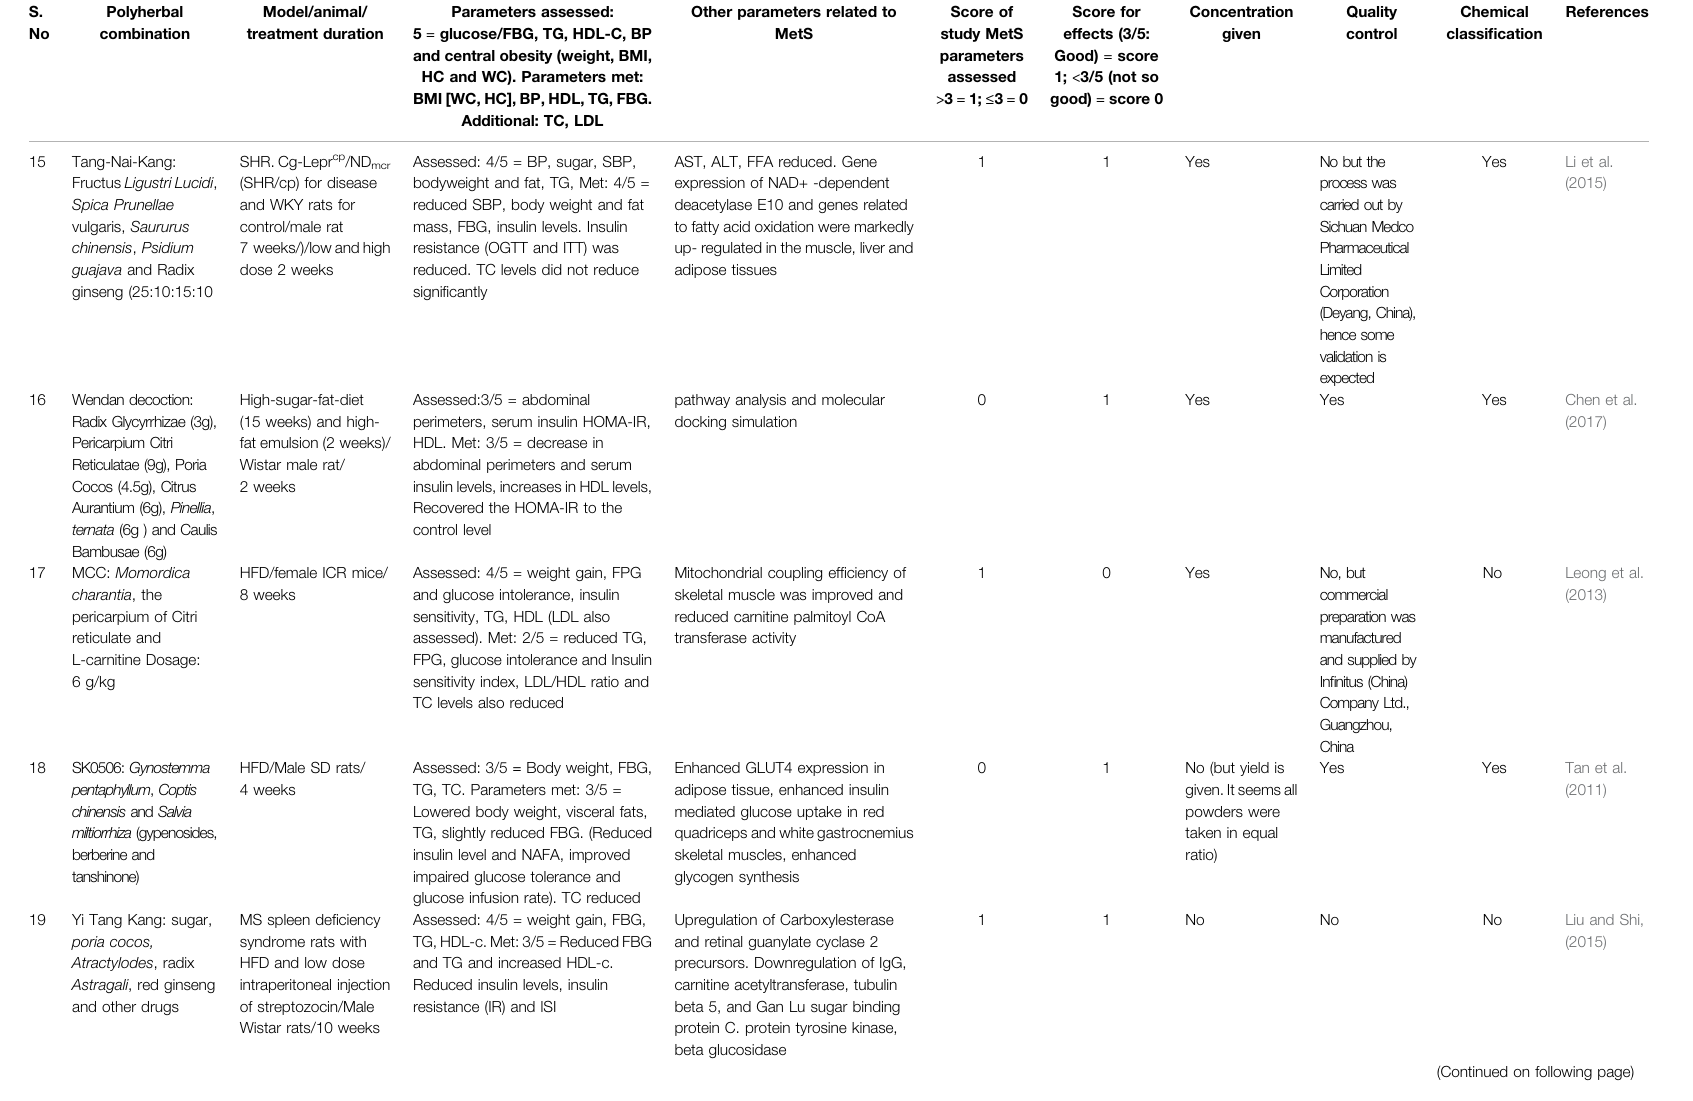
TABLE 3 | ( Continued ) Summary of metanalysis of Poly herbal combinations used in animal-based models of Metabolic